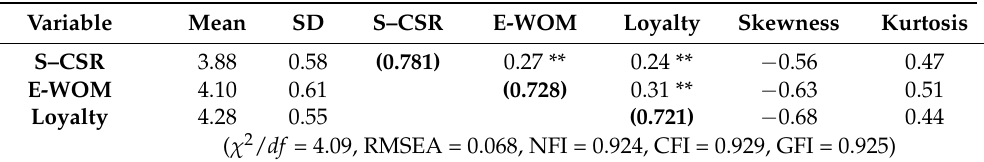
Table 3. Correlations and discriminant